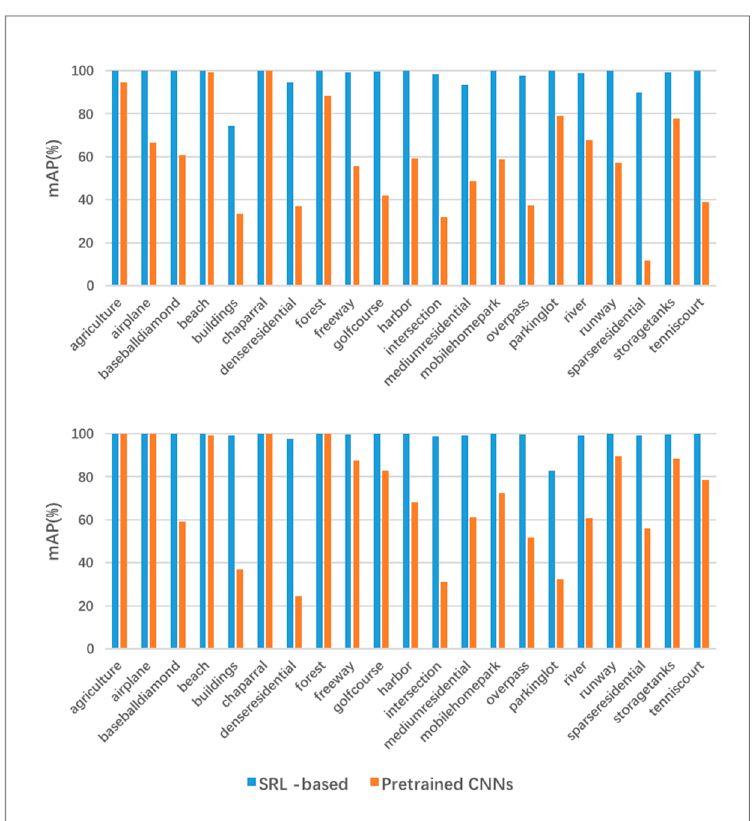
Figure 10. Evaluation of mAP is performed with VGG16 (top) and ResNet50 (bottom) on per-class in the PatternNet datasets trained with different features.